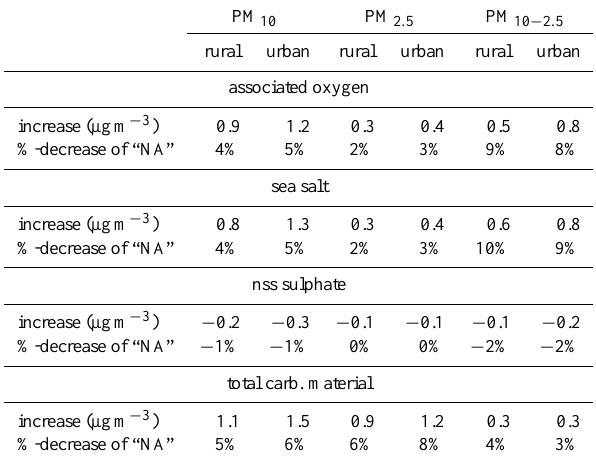
Table 3. Absolute and percentual change in mass concentrtion after applying conversion